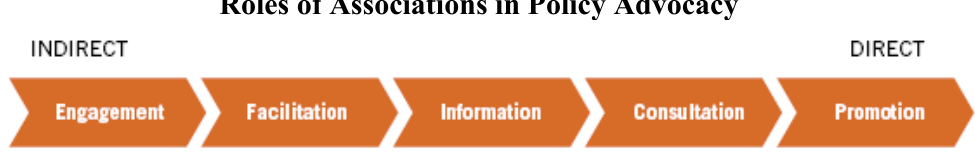
Roles of Associations in Policy Advocacy